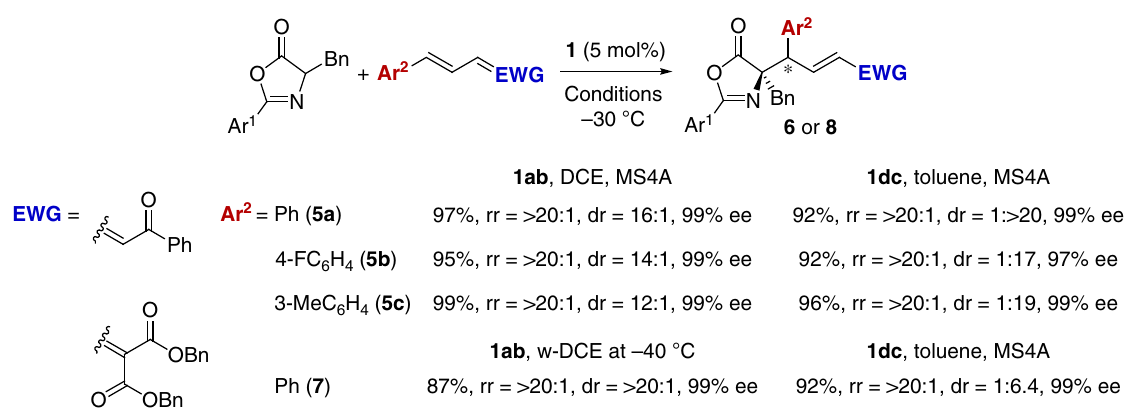
Figure 3 | Diastereodivergence in 1,6-selective conjugate addition to d -aryl dienyl carbonyl compounds (Ar 1 ¼ 2,6-(MeO) 2 C 6 H 3 ). Unless otherwise noted, all reactions were conducted under the optimized reaction conditions for 1,6-addition to d -aryl dienyl acylpyrroles 3 . Absolute stereochemistry of RR - 6ac was unambiguously determined by X-ray diffraction analysis (Supplementary Fig. 105).